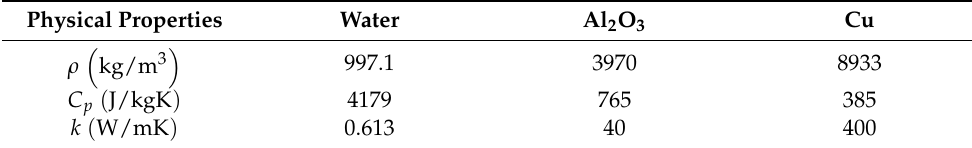
Table 2. Thermo-physical